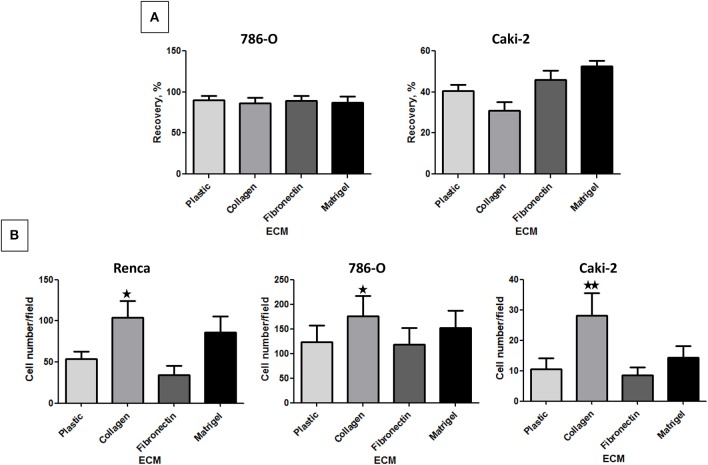
Effect of the different ECM components on RCC cell migration. (A) 786-O or Caki-2 cell migration was assessed in a scratch-wound assay with cells cultured on plastic, Col 1, FN1, or Matrigel. The kinetic of the cell migration into the wound was followed using an IncuCyte system (Essen BioScience). The percentage of wound closure was obtained after 24 h of cell migration, N = 4. (B) Renca, 786-O, or Caki-2 cell migration was assessed in a Transwell assay. Filters were uncoated (Plastic) or previously coated with Col 1, FN1, or Matrigel and FBS was used as chemoattractant. After 16 h, migrated cells were fixed and nuclei labeled. Five photos per well were taken and nuclei counted using ImageJ software. Renca: N = 4; 786-O: N = 5; Caki-2: N = 6. ⋆P < 0.05; ⋆⋆P < 0.01; ⋆⋆⋆P < 0.001.